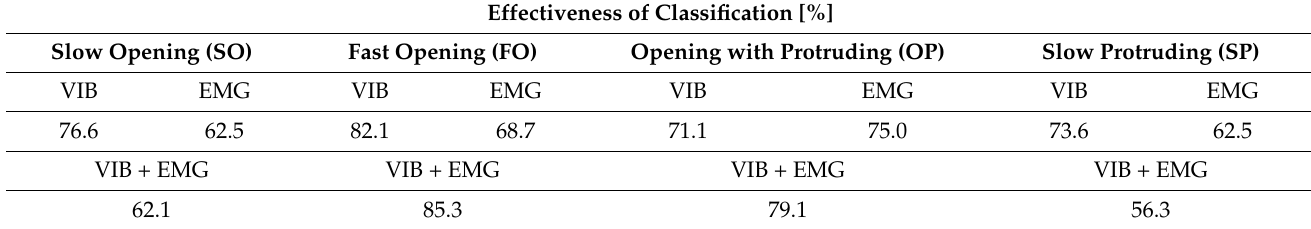
Table 4. Effectiveness of k-NN classification.